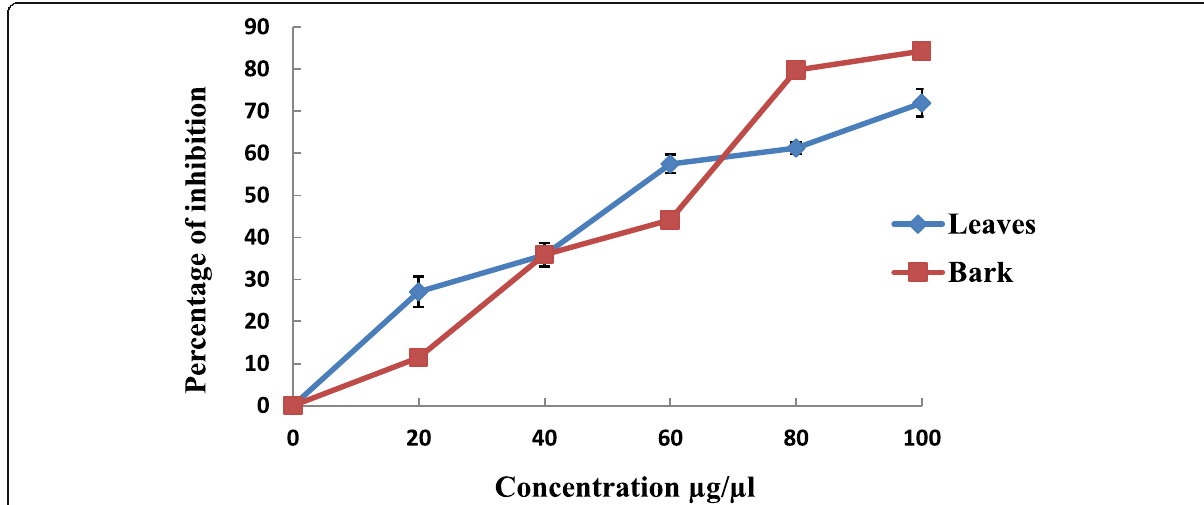
Fig. 11 Inhibition of superoxide radicals-riboflavin photoreduction method of S . palghatense leaves and bark. Error bars represent the standard error of observed data in all six replications